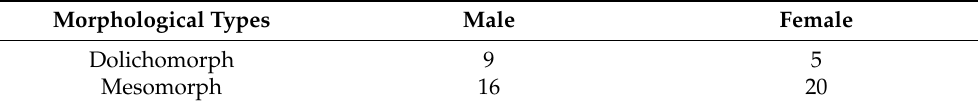
Table 1. Morphological type distribution according to sex. Morphological Types